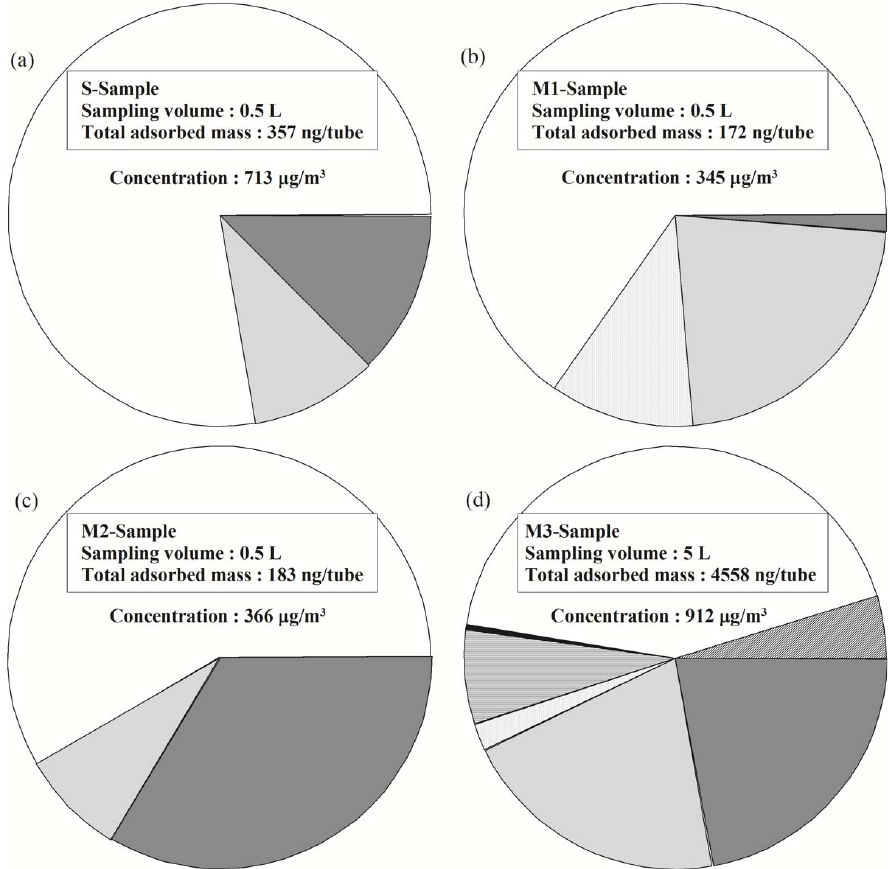
Figure 4. Composition of analytes sampled from the headspace gas in the concentration facility of wastewater treatment plant. Different sampling conditions (i.e., tube type, sampling volume, humidity pretreatment) were applied to each sample (Table 1). (Tube types: S ‐ Tube or M ‐ Tube, sampling volume: 0.5 L or 5 L, humidity control (in the M ‐ Tube sampling): silica gel or CaCl 2 with